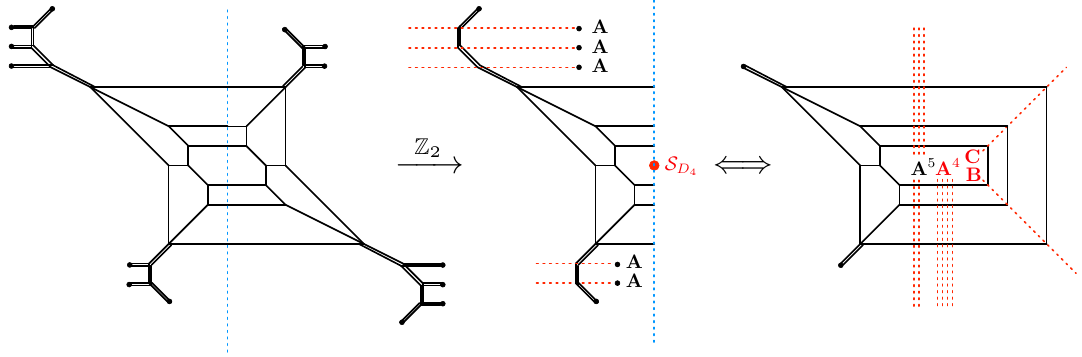
global symmetry. 8